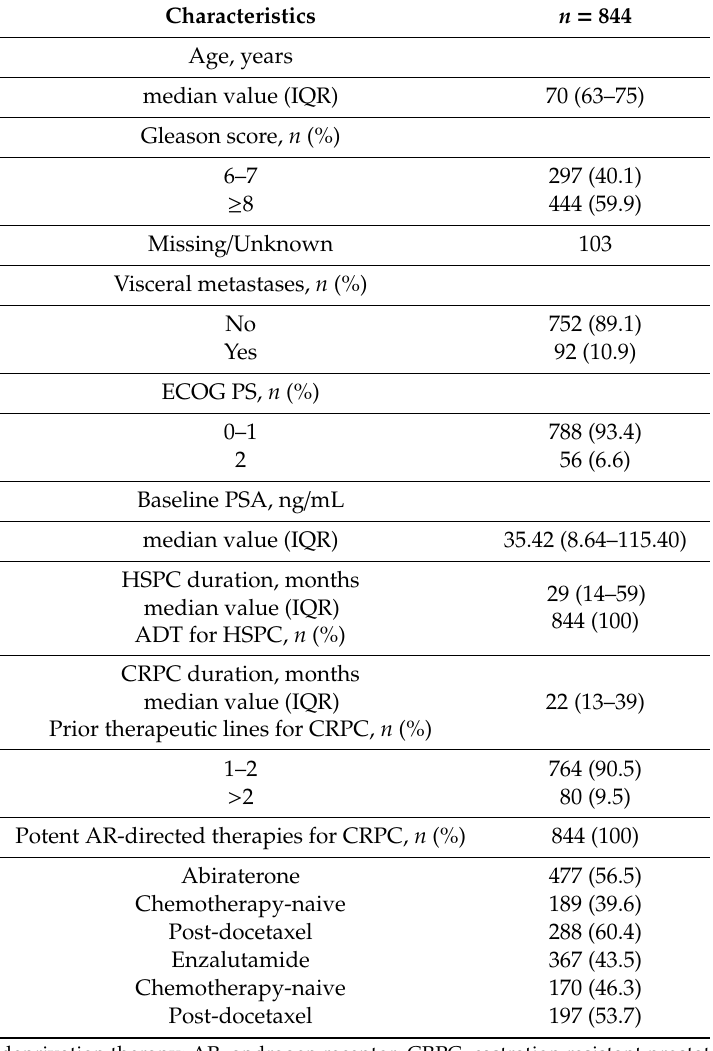
Table 1. Patient and treatment